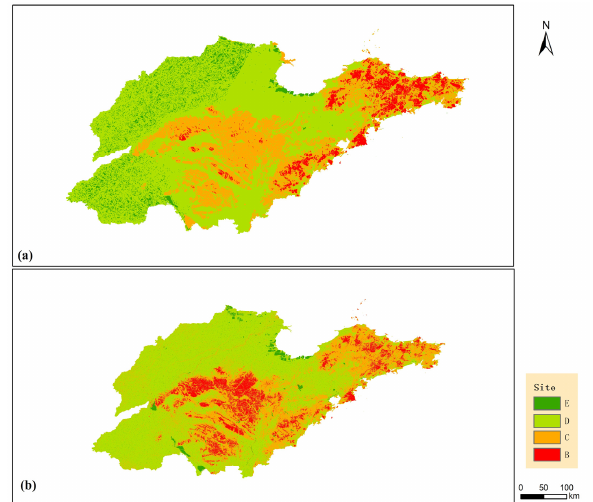
Figure 7. (a) The result of site classification in Shandong Province obtained from 30 arcsec DEM data. (b) The result of site classification in Shandong Province obtained from 3 arcsec DEM data.